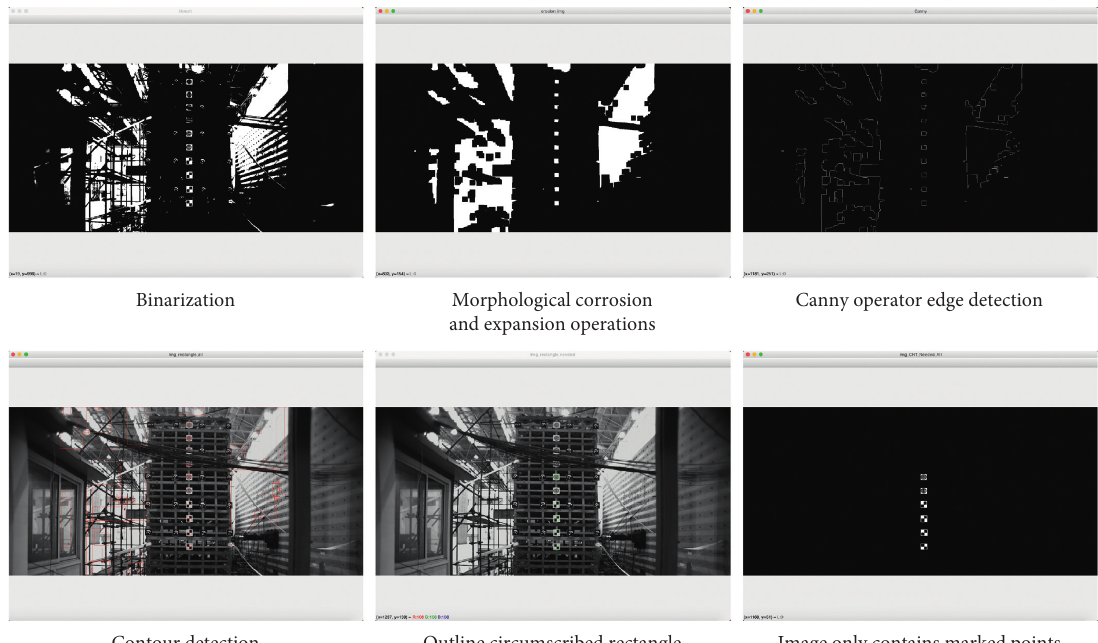
Figure 4: Computer vision-based maker recognition.